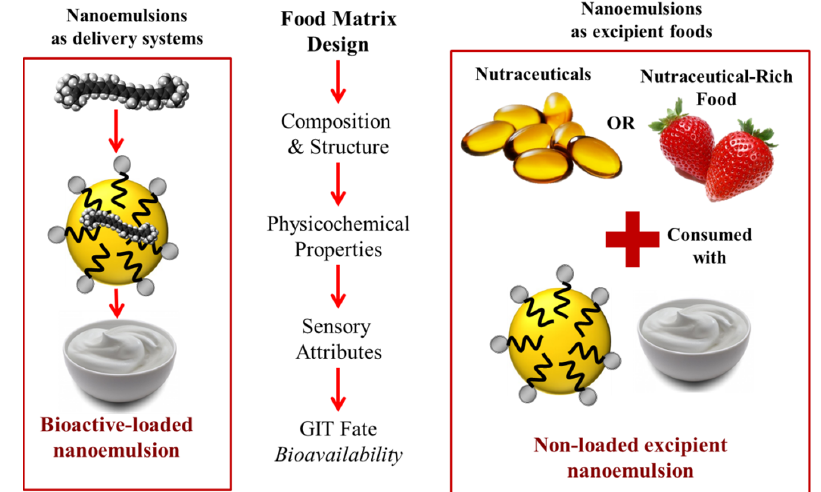
Figure 1. Schematic diagram of the difference between integrated and non-integrated excipient foods. For integrated excipient foods the bioactive component (pharmaceutical or nutraceutical) is dispersed within the excipient food matrix, but for non-integrated excipient foods the bioactive component is in another product that is co-ingested with the excipient food.